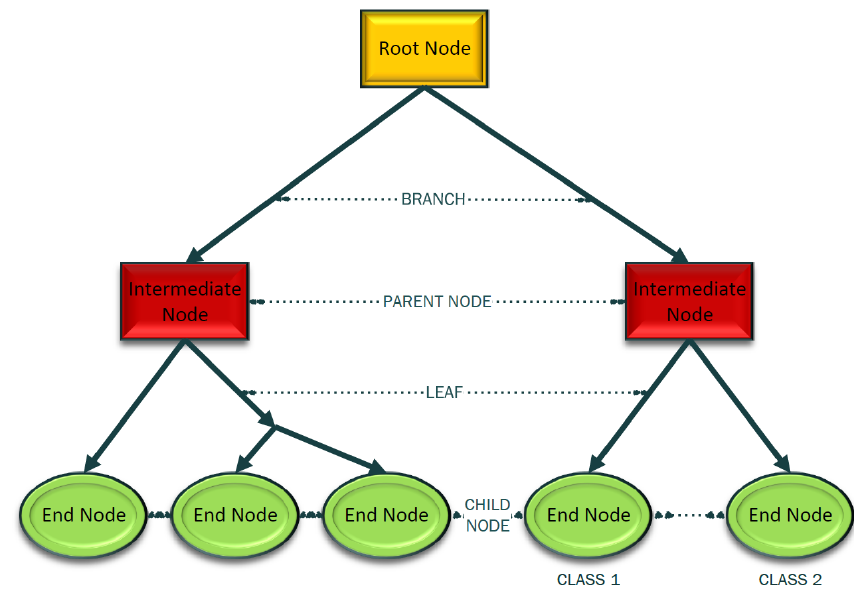
Figure 2. General Structure of the DT.